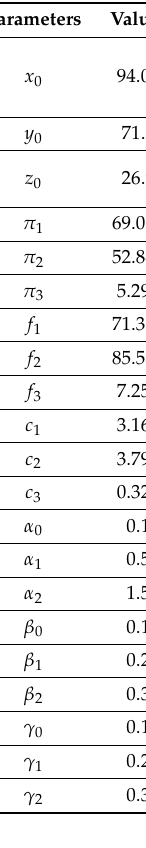
Table A1. The specific values and data